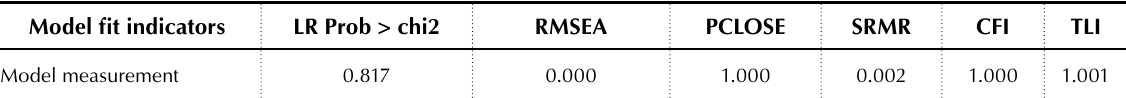
Table 1. Data measurement model fit